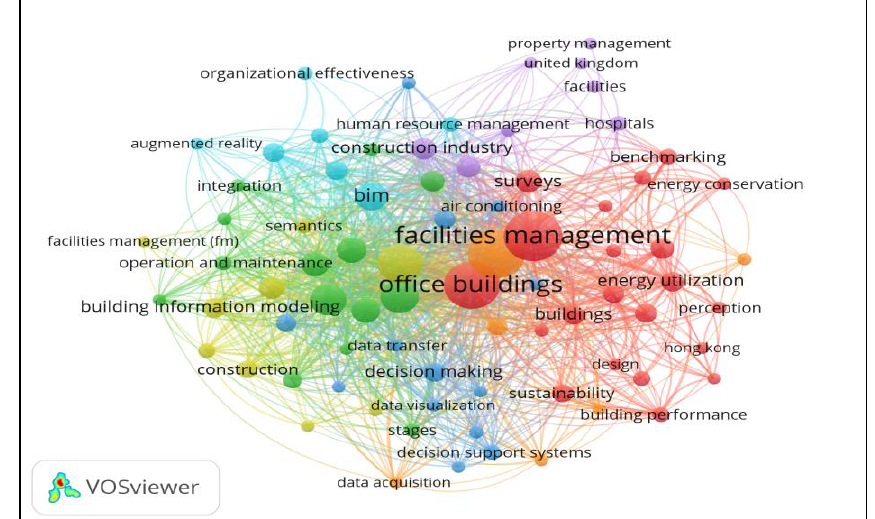
Figure 5: Network